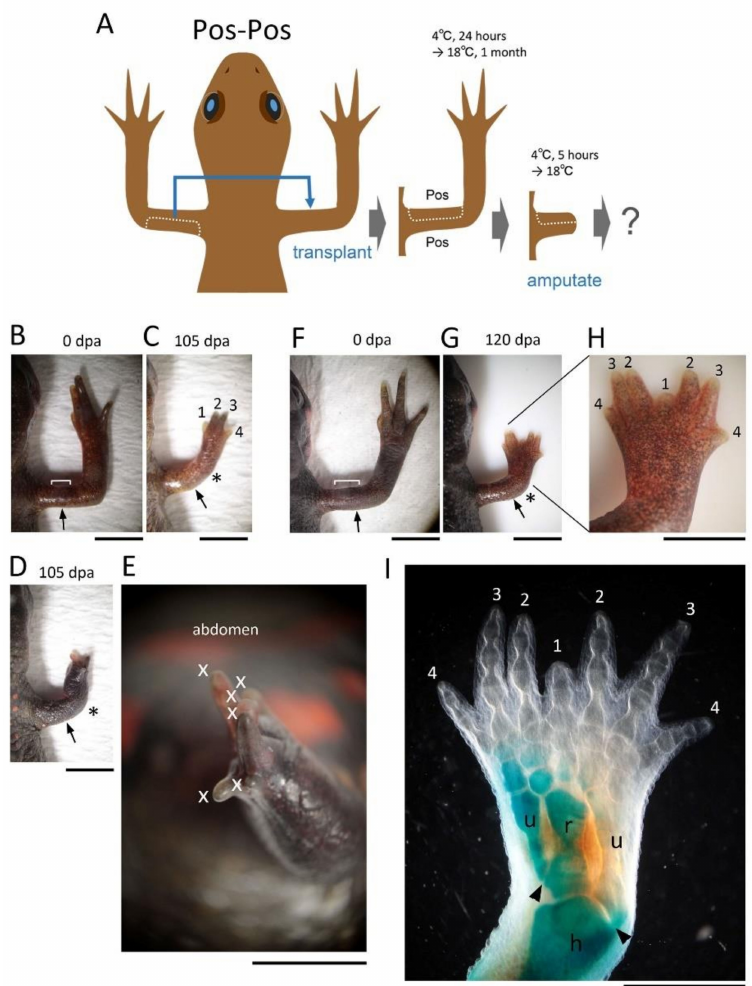
Figure 4. Effects of Posterior-Posterior (Pos-Pos) skin grafting on limb regeneration. ( A ) Schematic showing the surgical process. ( B , C ) Representative showing normal regeneration (n = 13). ( D – I ) Rarely occurring abnormal limbs. ( D , E ) A limb with excessive digits on a hand with